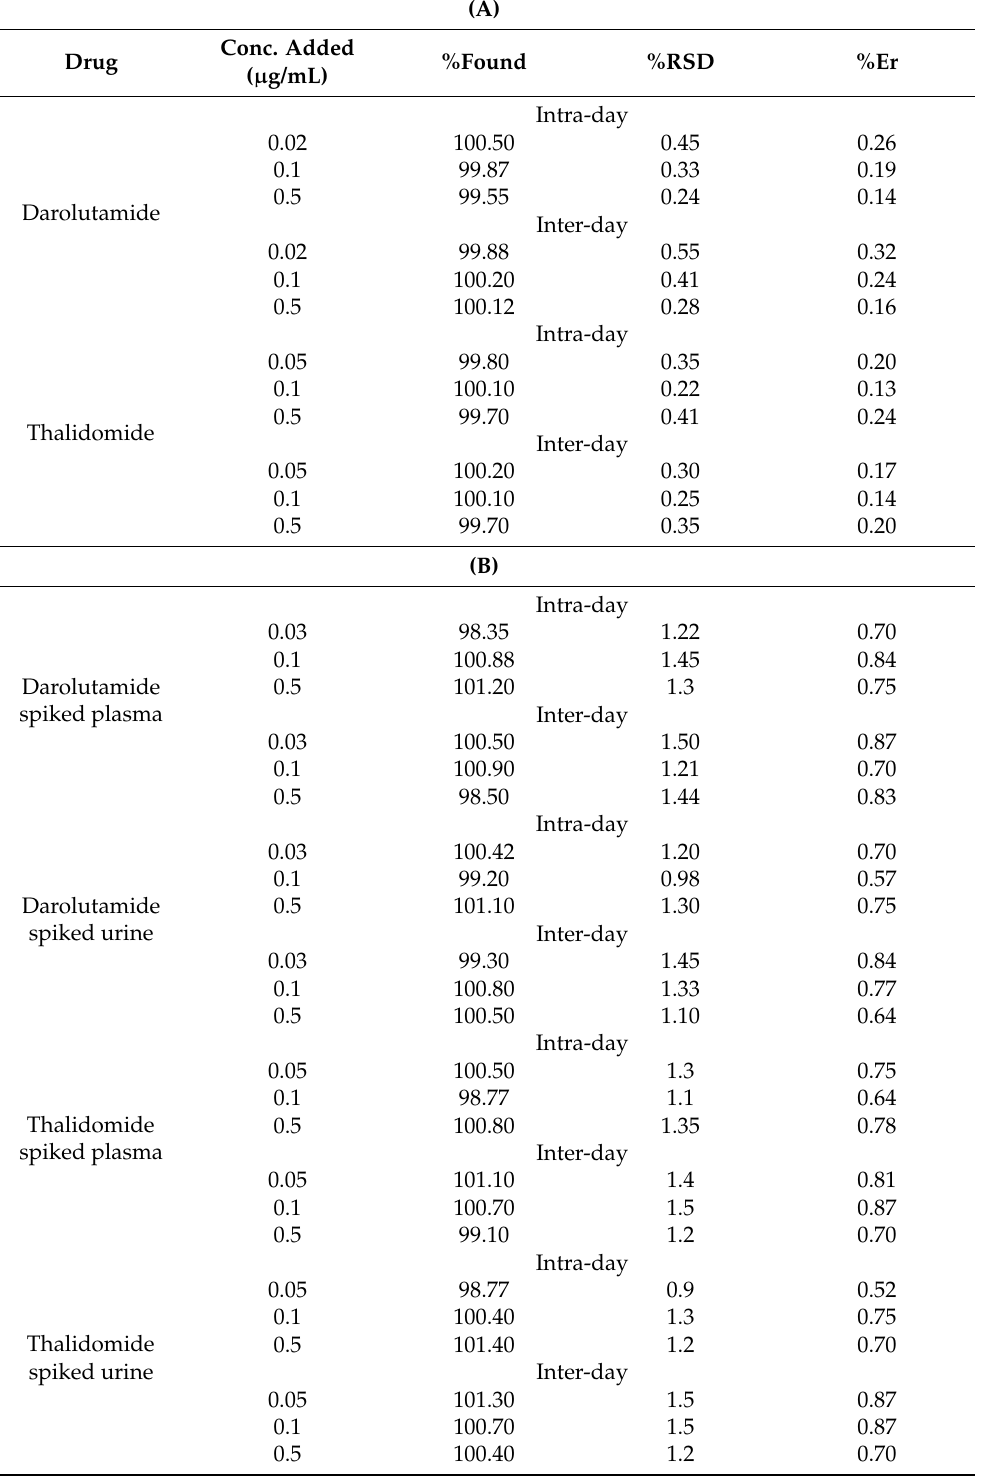
Table 1. ( A ): Intra-day and inter-day precision of the proposed method for analysis of darolutamide and thalidomide raw materials. ( B ): Intra-day and inter-day precision of the proposed method for darolutamide and thalidomide analysis in spiked plasma and urine.